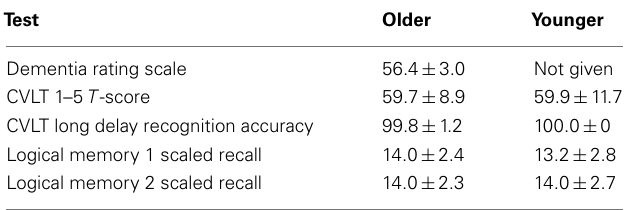
Table 2 | Neuropsychological test